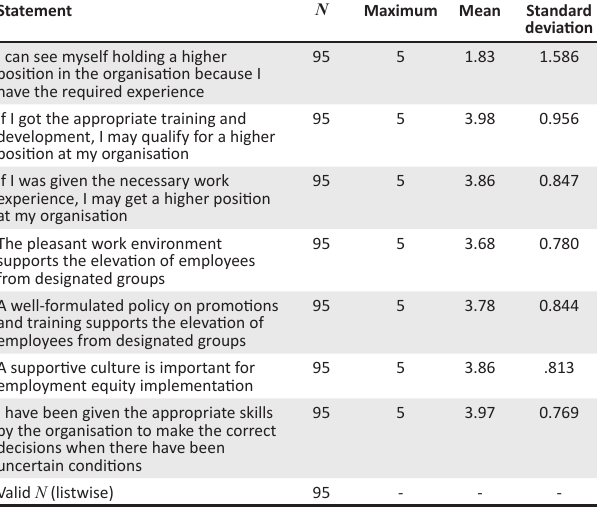
TABLE 4: Descriptive analysis ( n =